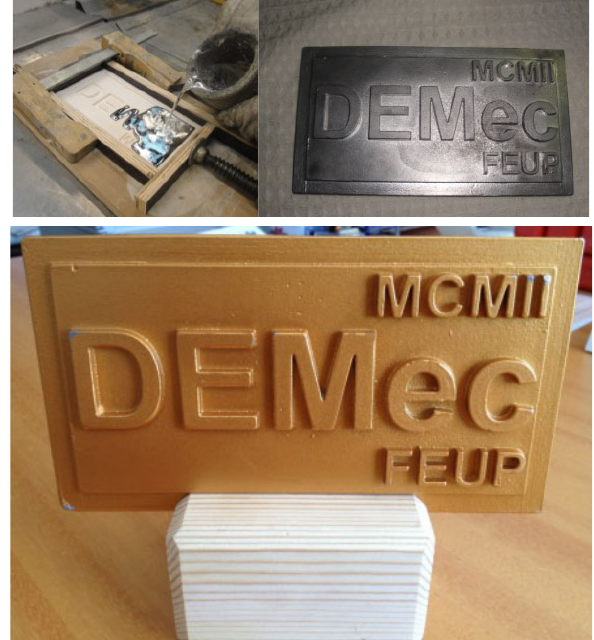
Figure 11. Casting the low melting point alloy and final part.